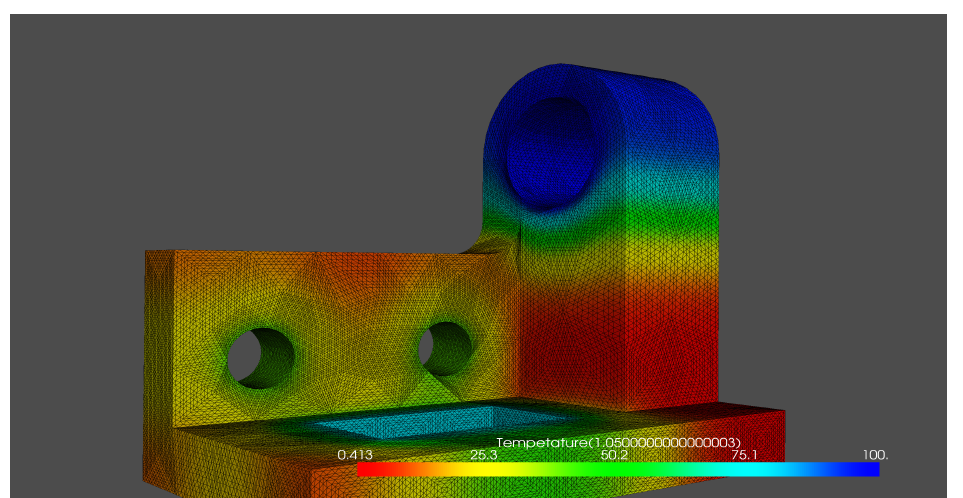
Figure 14. Temperature contour of a function space of order 3 at t = 1.05 s.